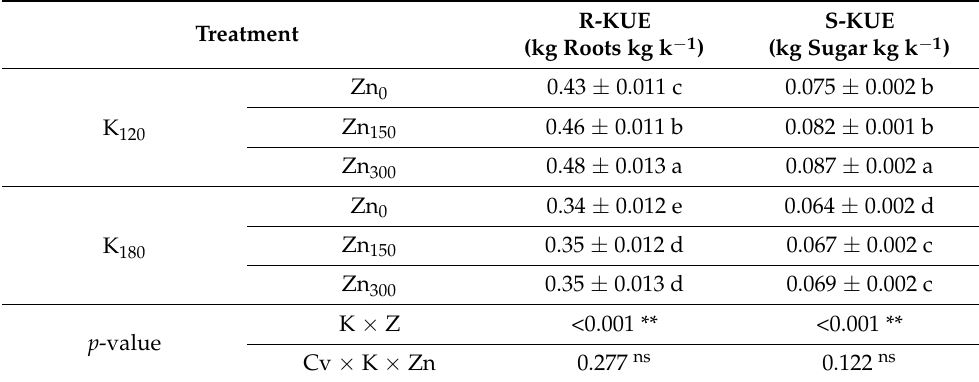
Table 8. Potassium use efficiency (based on root yield (R-KUE) and pure sugar yield (S-KUE)) of sugar beet affected by the interaction of soil fertilization with two potassium levels (e.g., 120 (K 120 ) and 180 kg ha − 1 (K 180 )) and foliar application with three zinc levels (e.g., 0 (Zn 0 ), 150 (Zn 150 ), and 300 ppm (Zn 300 )) when grown under saline soil (EC e = 8.60 dS m − 1 ) conditions over both sugar beet cultivars (data pooled over both